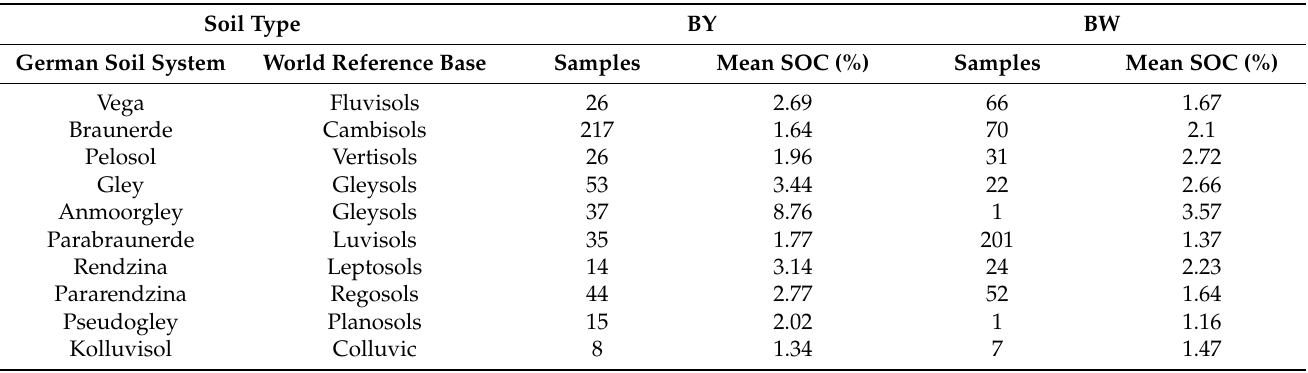
Table 4. Soil types and mean SOC content at the sampling locations. Main soil types were extracted from the German Soil Map (BÜK200) [35] and converted to the units of the World Reference Data